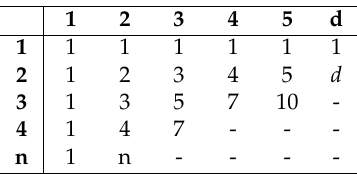
Table 1. Known maximum Waring ranks in S d , with dim S 1 = n